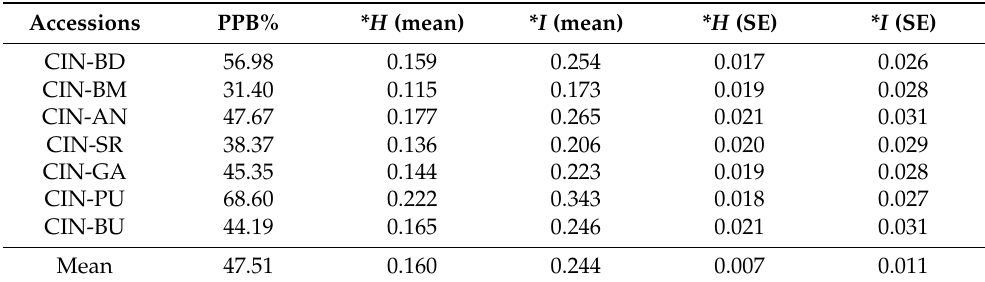
Table 5. Percentage polymorphic bands (PPBs), Nei’s genetic diversity ( H ), and Shannon’s informa- tion indices ( I ) for ISSR in C. intybus L.